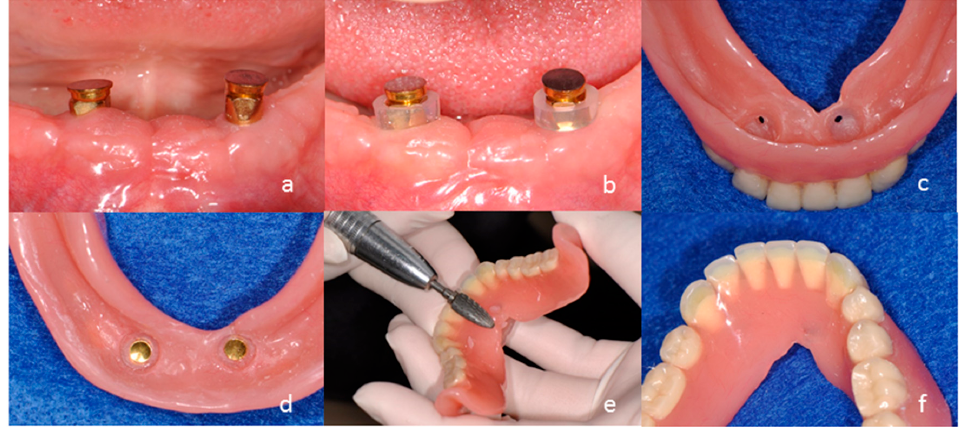
Figure 9. Installation of magnet assembly to the new overdenture using an auto-curing acrylic resin. Place the metal-adhesion-treated magnet assembly ( a ); Set the silicone tube on the keeper ( b ); Make a hole though denture base ( c ); Apply the resin material and fix the magnet assembly to the denture base ( d ); Remove the extra resin ( e ); Polish ( f ). The magnet assemble should be fixed to the denture base with the load, or after the overdenture is settled down to the oral